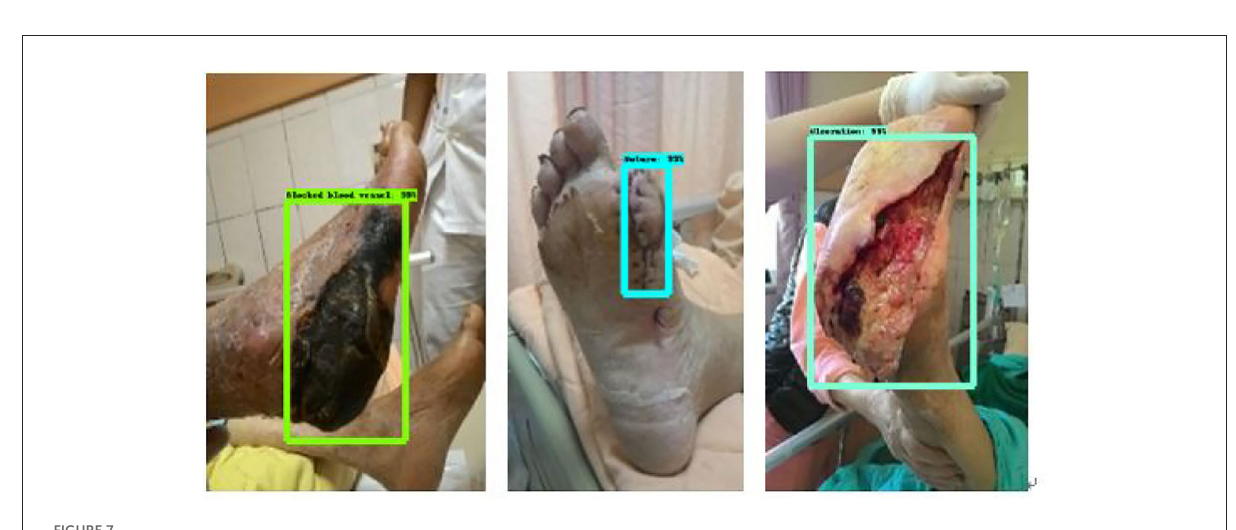
FIGURE7 Identification results